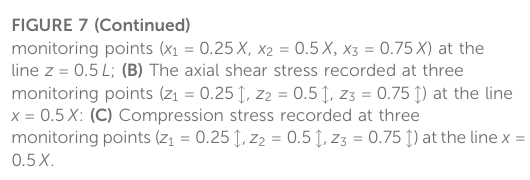
FIGURE 7 The comparison of rough and smooth model historical variations in stress were recorded by monitoring the points calculated by FLUENT (blue line: rough model; red line: smooth model). (A) The transverse shear stress recorded at three